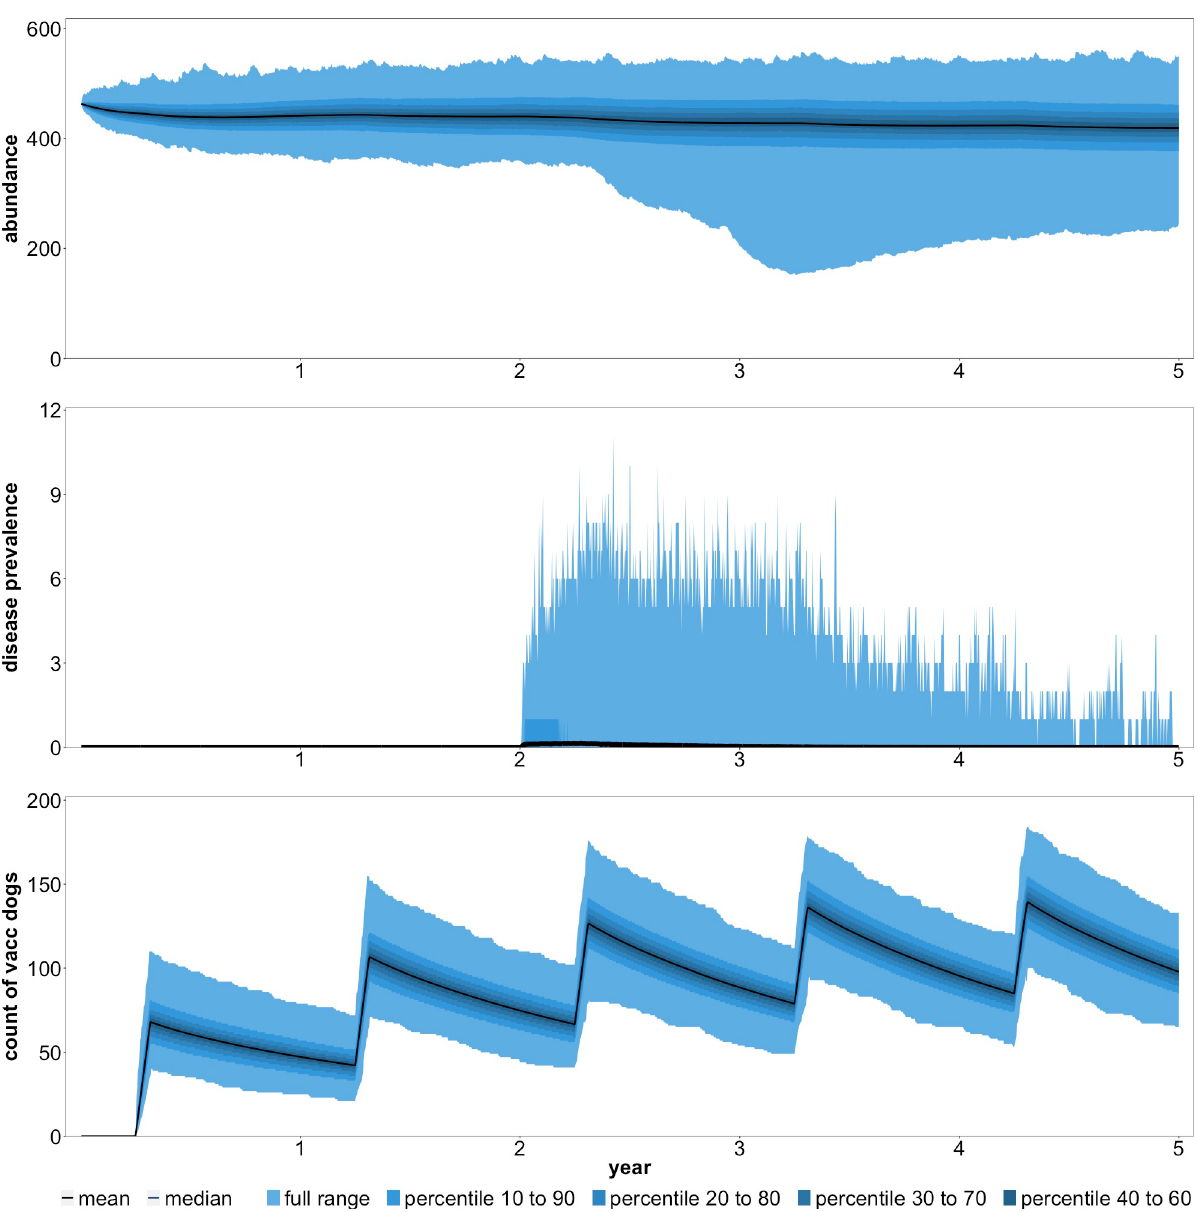
Fig 6. Abundance, disease cases, and vaccine coverage with annual vaccination (inc. puppies), female sterilization, and a total budget of